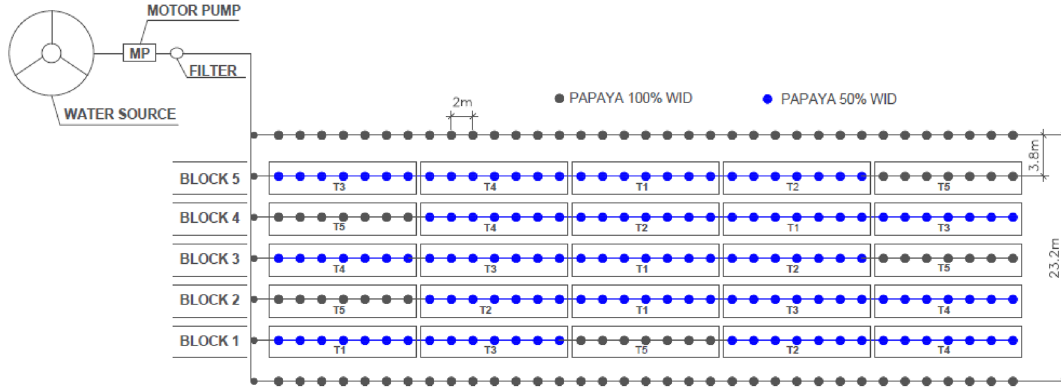
Figure 4. Placement of treatments in the field: T1—plant row side-shifting-frequency of 7 days (50% WID), T2–plant row side-shifting-frequency of 14 days (50% WID), T3—plant row side-shifting-frequency of 21 days (50% WID), T4—only one plant-row side irrigated (50% WID) and T5—Both plant-row sides irrigated (100%